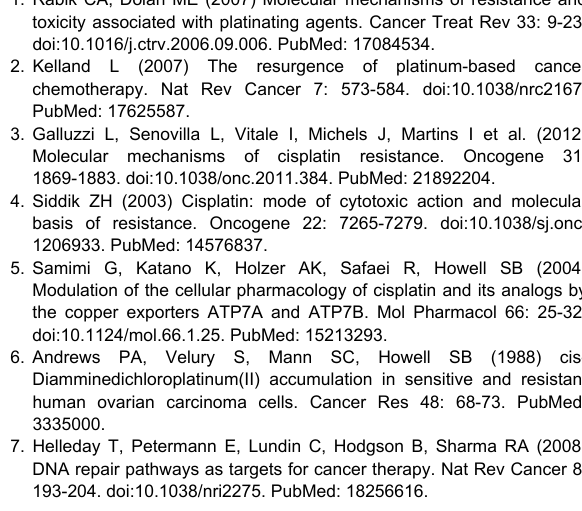
Figure S1. Model for DNA damage tolerance by template switch. Provoked by a bulky lesion (star) in the leading strand template, the proposed interplay of recombination proteins, PCNA ubiquitination and DNA polymerases in filling a single- stranded gap is depicted. Adapted from [28]. (PDF) Figure S2. Relative cisplatin sensitivity of haploid yeast mutants in agar diffusion assays. For these semiquantitative streak tests, early-logarithmic phase BY4741 wild-type or mutant cell cultures were concentrated to 4x10 7 cells/ml. Of these suspensions, 10 µl samples were streaked on YPD plates in a radial fashion, and 250 µl of 1.5 mM CP were pipetted in the circular center hole (0.5 inch diameter). Plates were kept at 4°C for 3 hours to allow for CP diffusion before incubating at 30°C. Streaks were photographed after 30 hours. (PDF) Figure S3. Flow cytometric DNA profiles of G1- synchronized cells released into fresh medium after treatment with cisplatin, NSC109268 or both. Wild-type (A) or RAD5 -deleted cells (B) of BY4741 were synchronized with α-factor and then sequentially incubated with CP and NSC10268 before release into fresh YPD medium, as described in Material and Methods. Samples were taken for a period of 100 or 120 min past treatment. Proper control regimens (mock treatment, CP alone, NSC10268 alone) were applied for comparison and are indicated in the figure. (PDF) Figure S4. Absence of evidence for direct of indirect influence of inhibition of protein degradation on sensitization to cisplatin by NSC109268. (A) The absence of a non-additive effect of the combination of bortezomib and CP